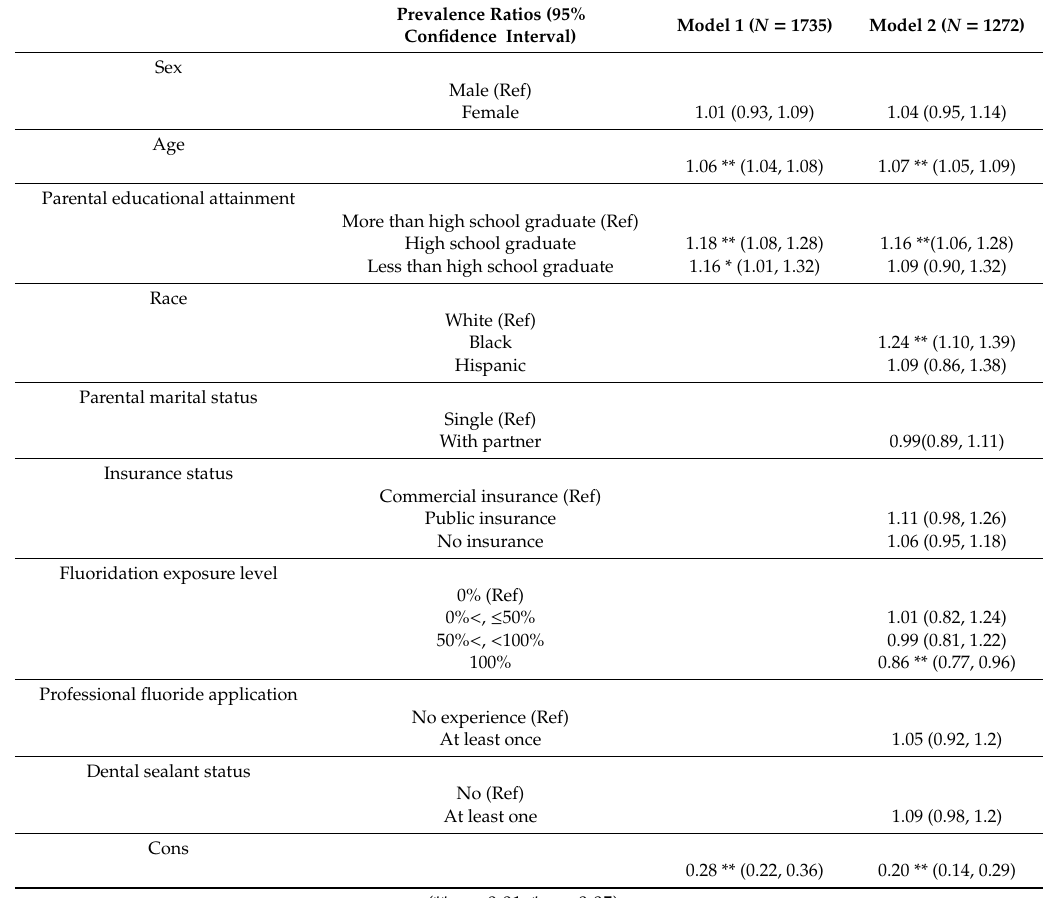
Table 2. Results of Poisson models for all samples.